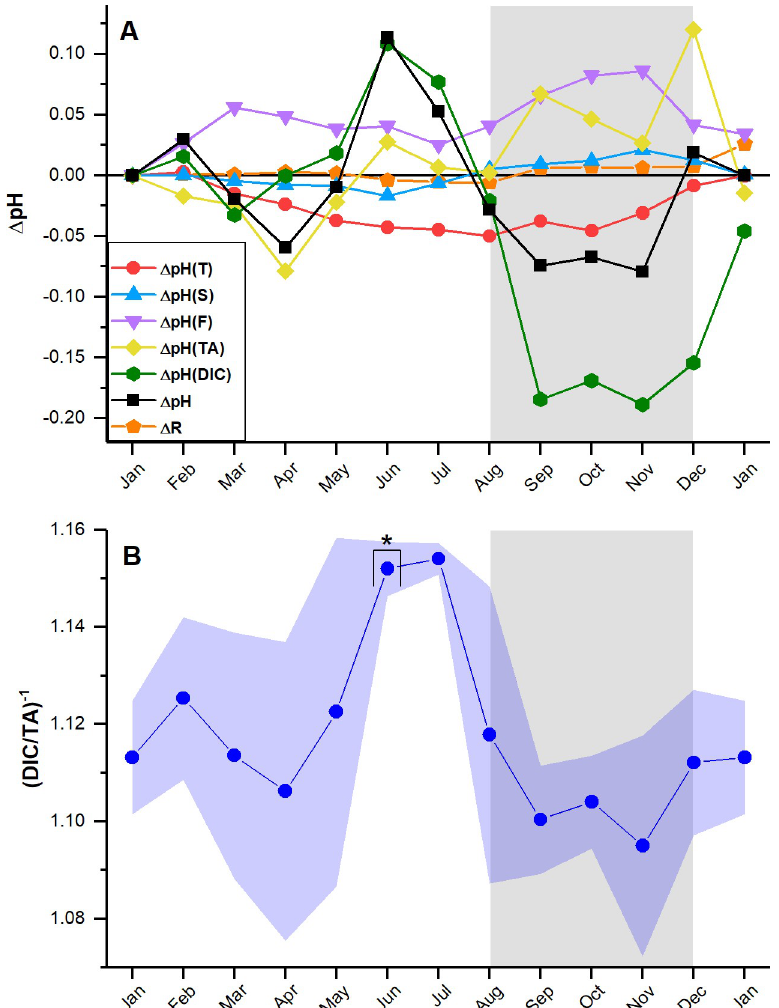
Fig 6. Results of the pH decomposition. (A) Cumulative monthly changes in pH (black line) due to temperature (red), salinity (blue), CO 2 flux (violet), TA (yellow), and DIC (green). The analysis considered January as the starting point and added the changes from thereon. (B) Seasonal variability of the inverse DIC/TA ratio. The blue shade represents one standard deviation for each monthly mean. For each data point, n � 2. Data points depicted with an asterisk show where n = 2. The gray shades in both plots represent the wet